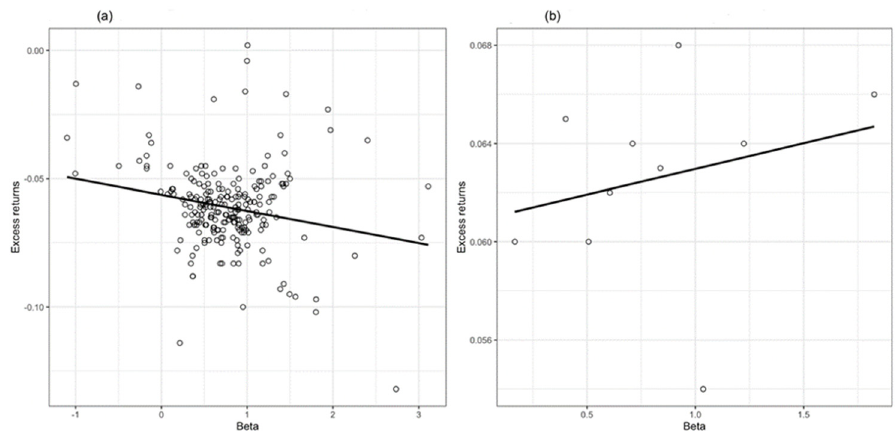
Figure 1. Relationship between betas and excess returns for individual stocks ( a ) and portfolio of stocks ( b ).